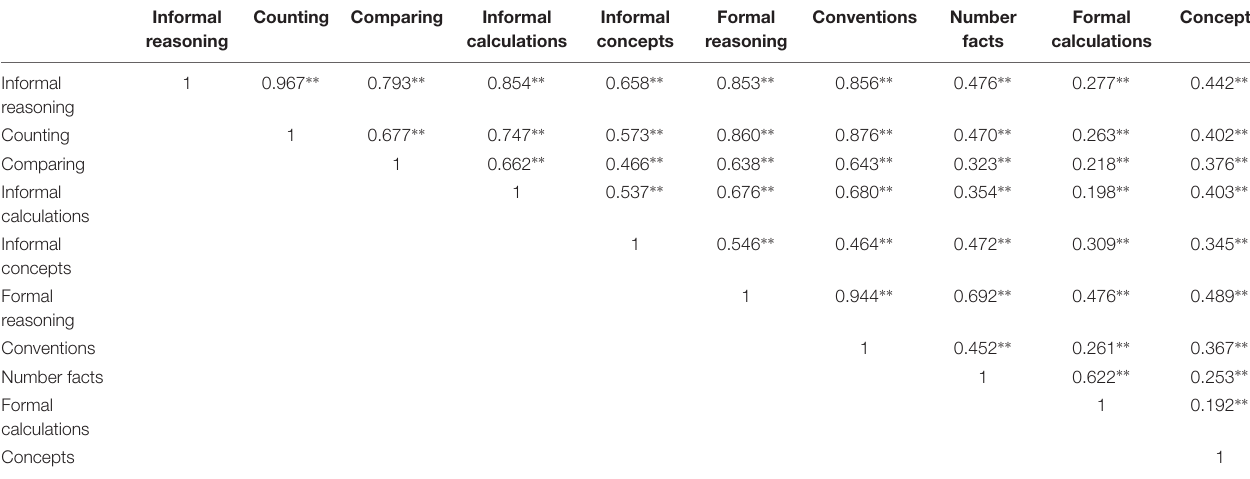
TABLE 1 | Correlation matrix of the student scores in formal and informal mathematical thinking subtest of